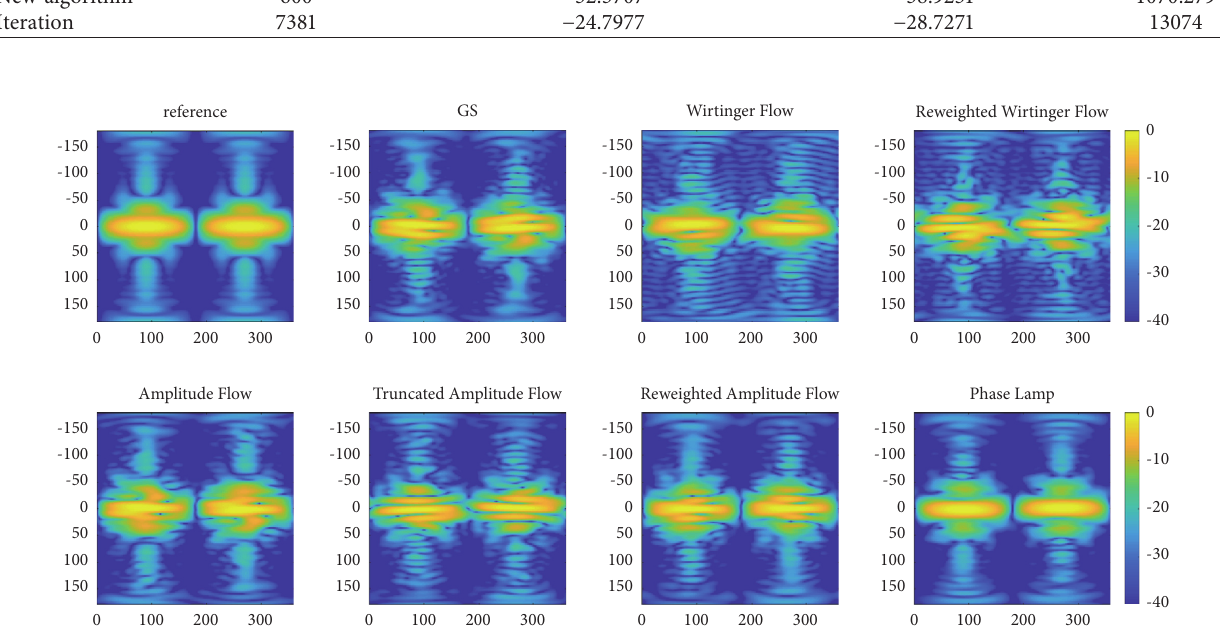
Figure 18: The reconstructed E